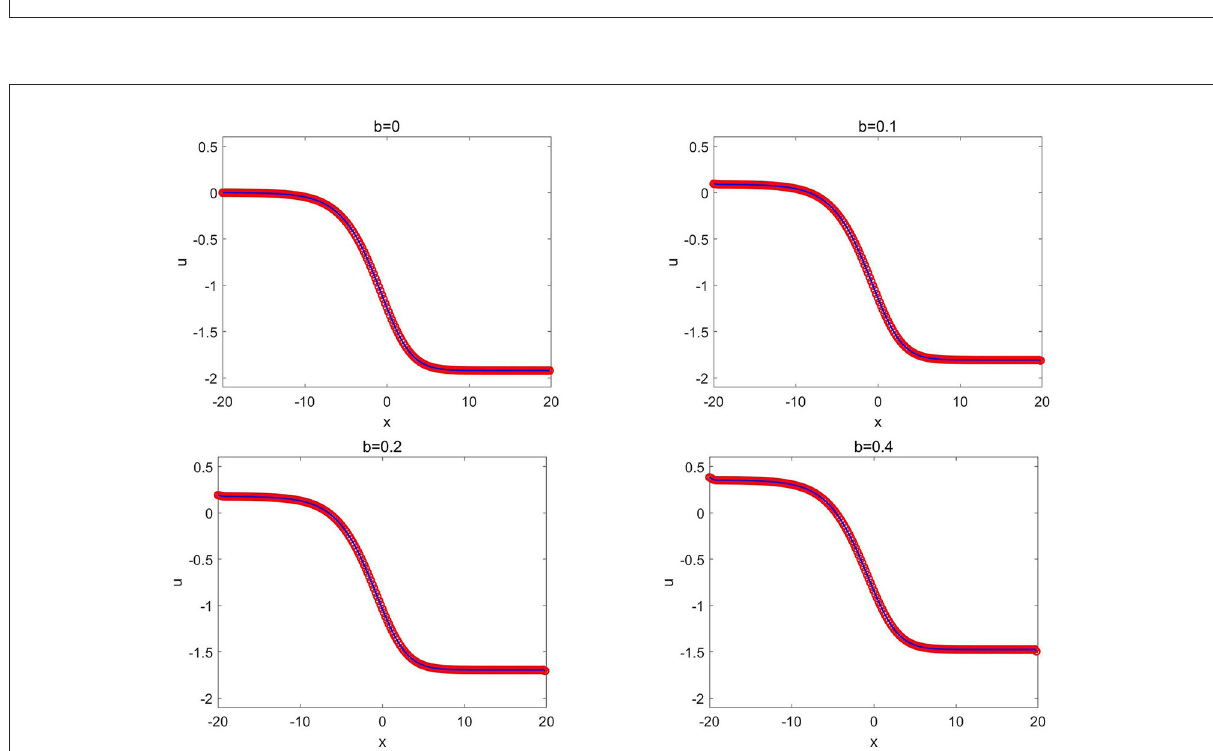
1.0 with different θ . =